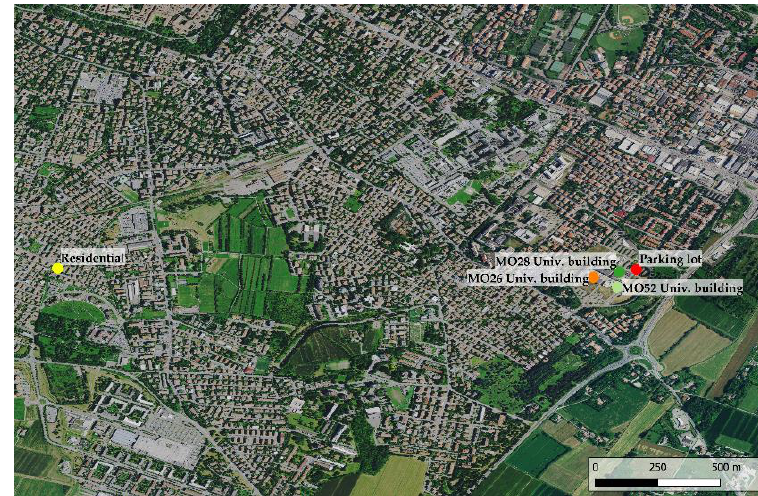
Figure 4. Analyzed surfaces in the south area of Modena. Table 3. Analyzed surfaces and color codes for the spots on the map in Figure 4. Label